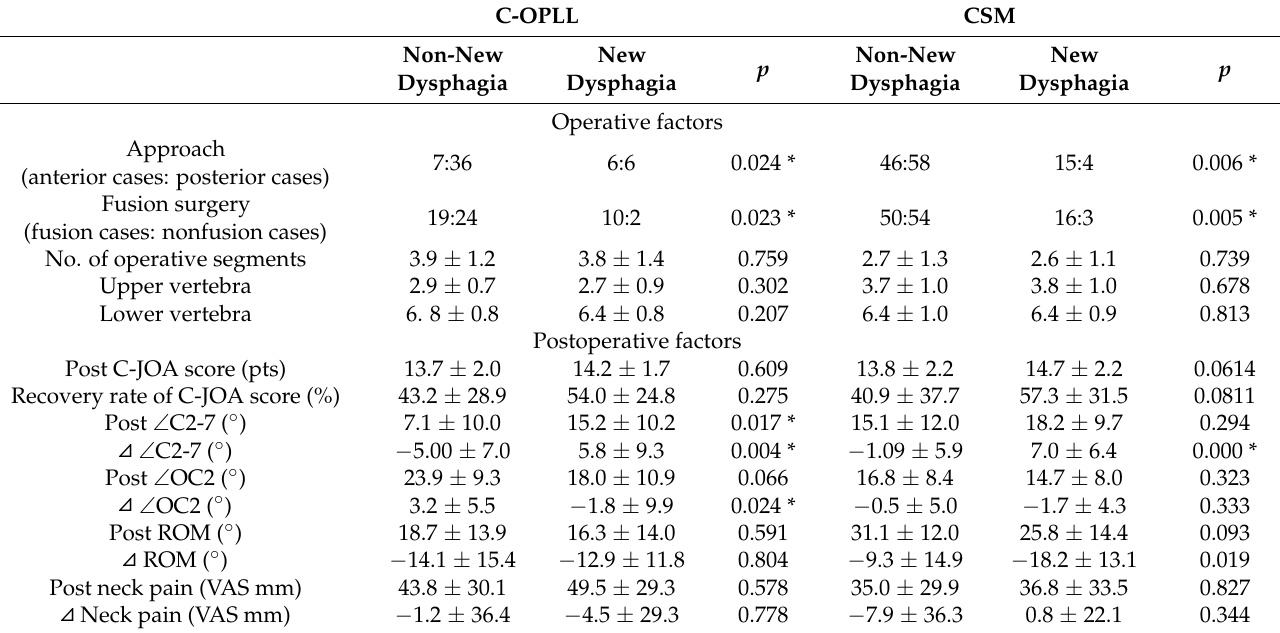
Table 7. Risk factors of new dysphagia at 1-year after surgery.